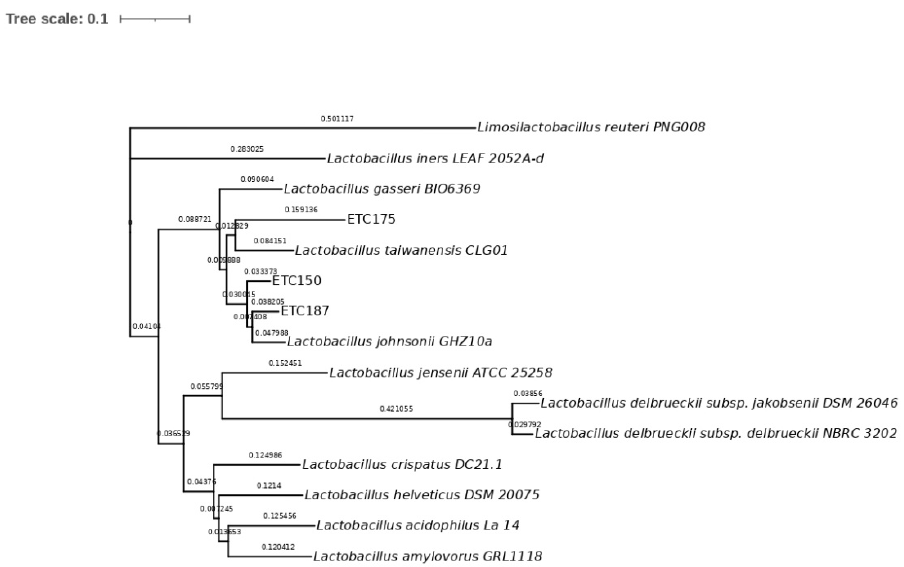
Figure 3. Maximum-likelihood tree with tuf gene sequences. Bar, 10% nucleotide substitutions.